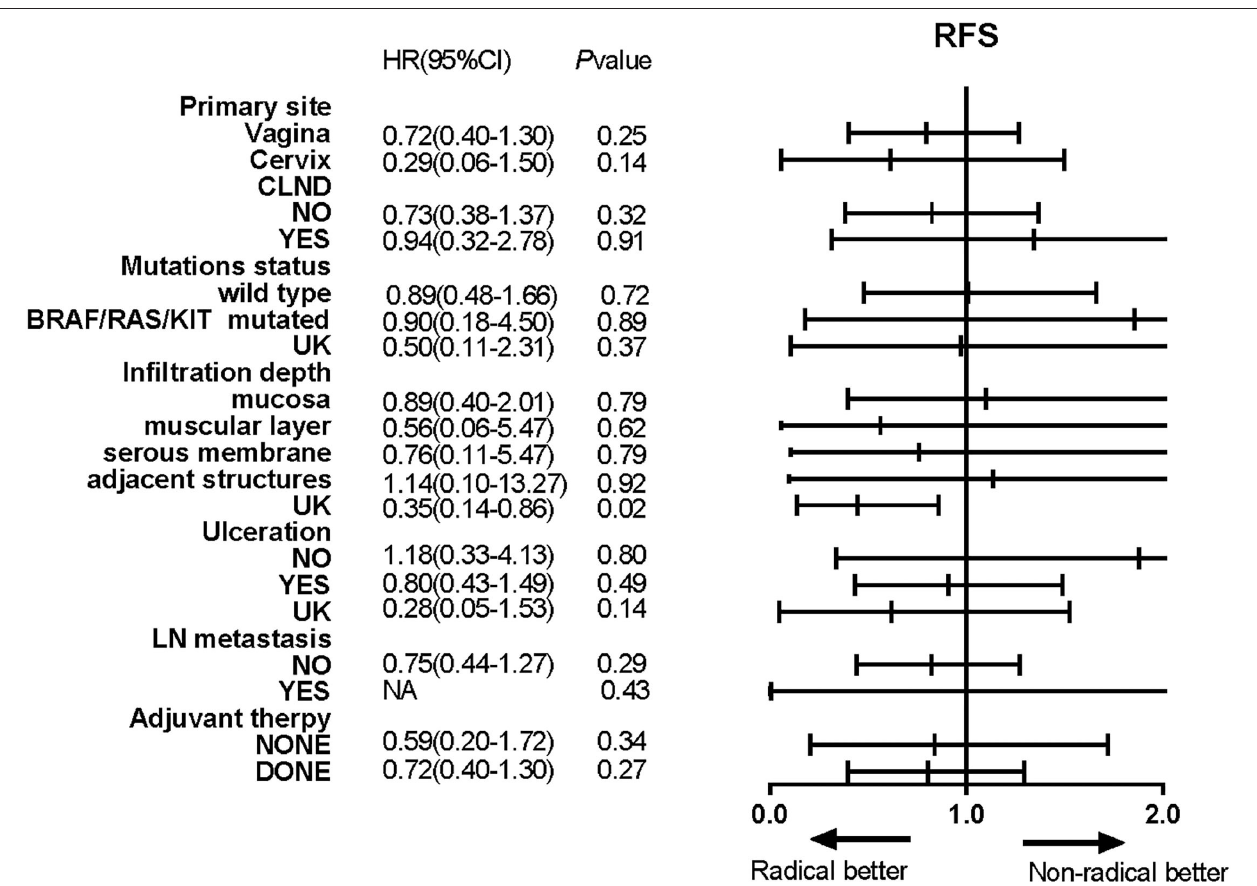
FIGURE 6 | Forest plots showed the results of univariate analyses of recurrence-free survival (RFS) in different subgroups. Hazard ratios (HRs), their associated 95% confidence intervals (95% CIs) and P -values were calculated for each subgroup